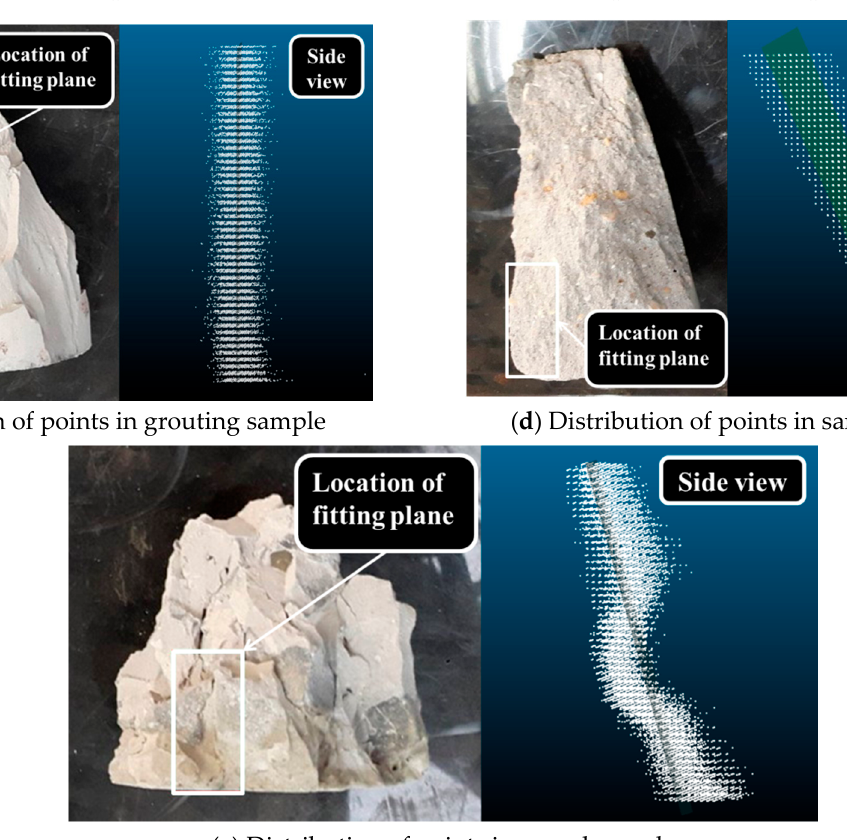
Figure 7. Fitting planes and distribution of points within the fitting plane for each sample.